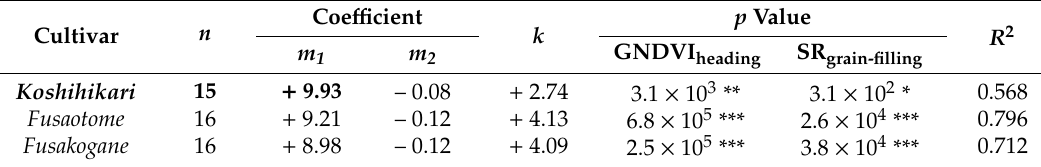
Table 3. The results of multiple regression analysis for rice grain protein content estimation. n =